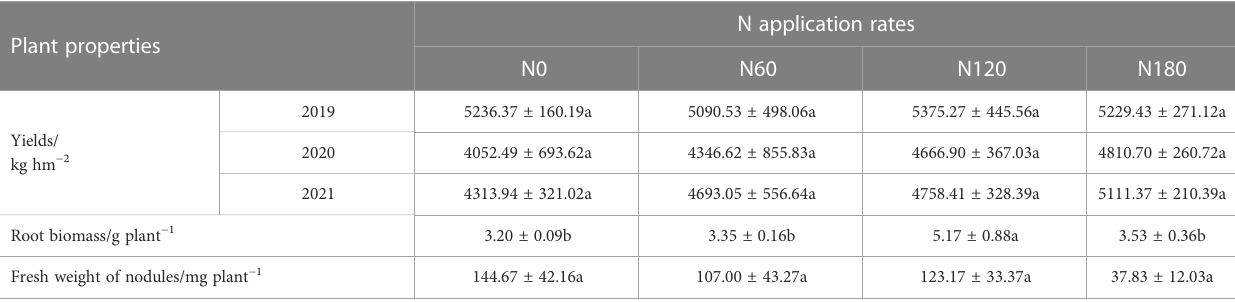
TABLE 2 Plant properties affecting the rhizosphere soil microbial communities sampled in August 2021.